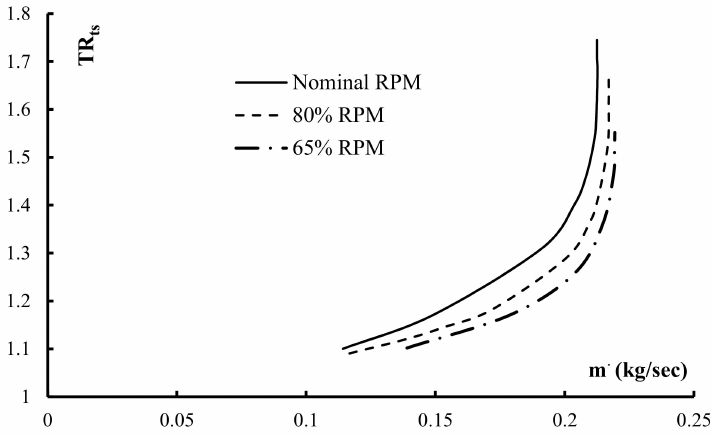
Figure 17. Evolution of total-to-static temperature with mass flow rate for the new design of RI